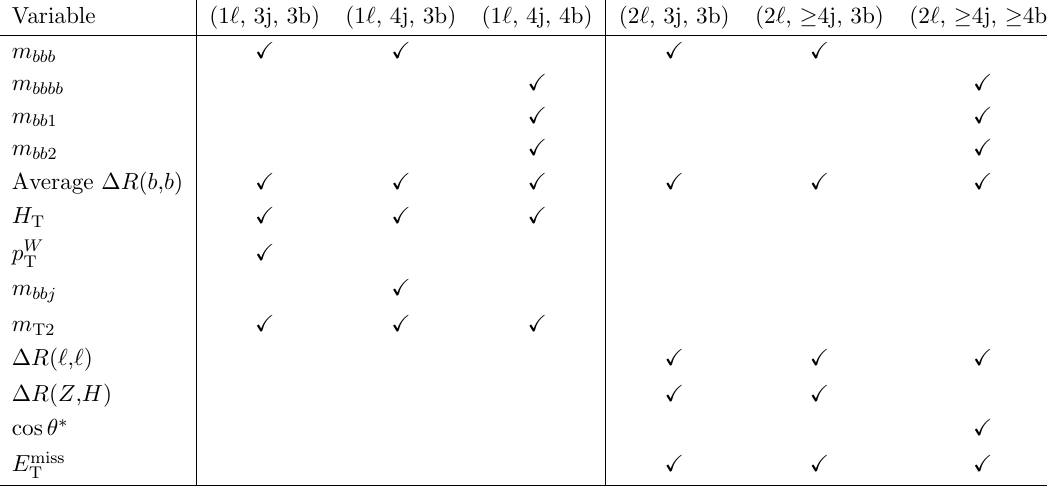
has an endpoint T2